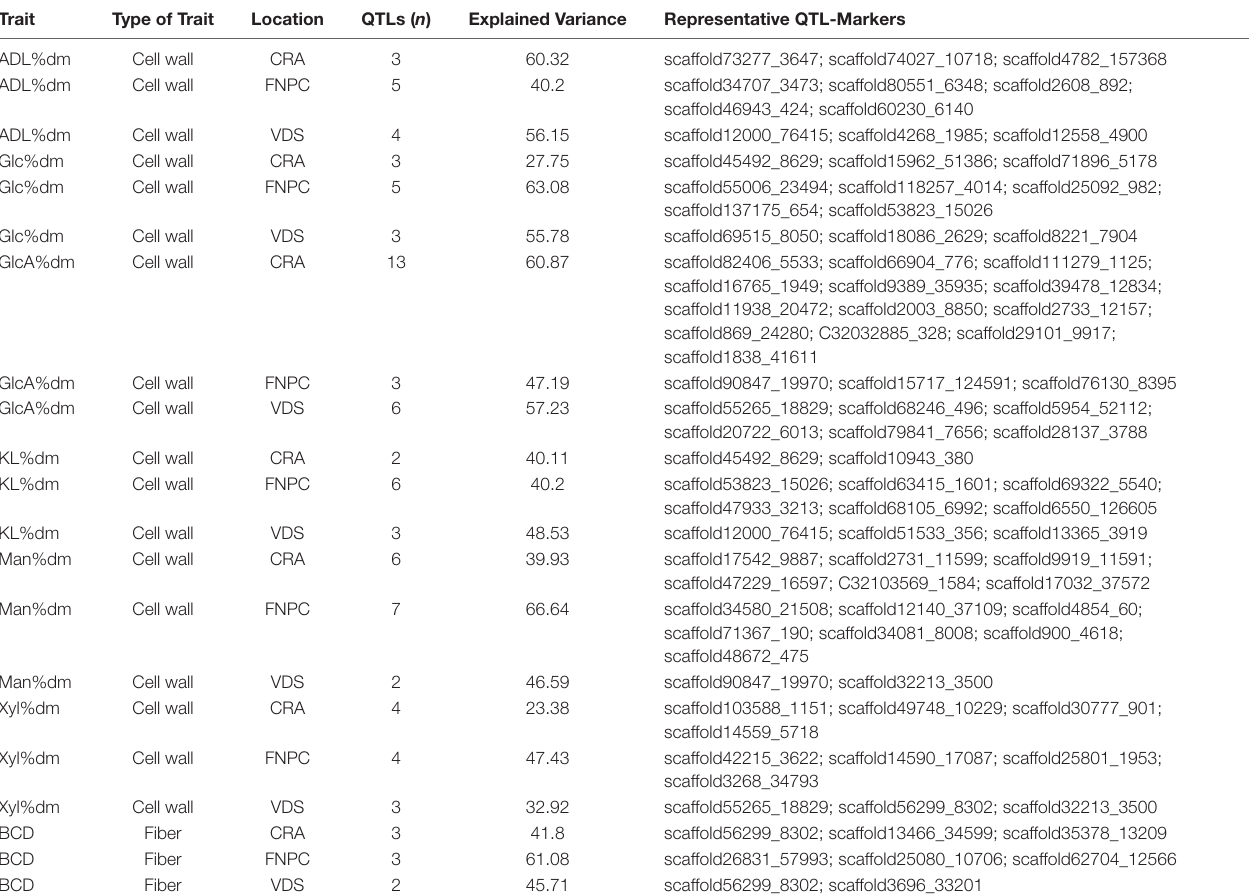
TABLE 2 | Quantitative trait loci (QTLs) for fiber and cell wall traits of hemp. Trait Type of Trait Location QTLs ( n ) Explained Variance Representative